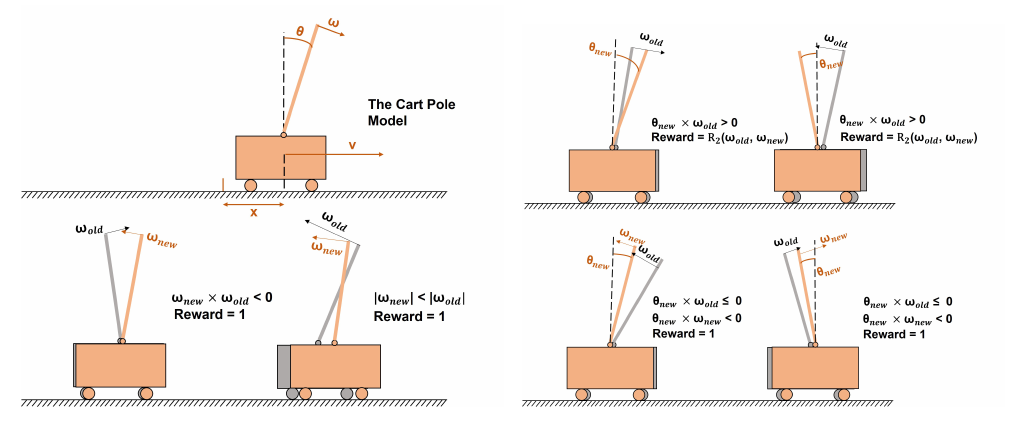
Figure 4. Different reward function designs: ( a ) Reward Function 2 employs the angular velocity of the pole; ( b ) Reward Function 3 employs the angular velocity of the pole as well as the angle of the